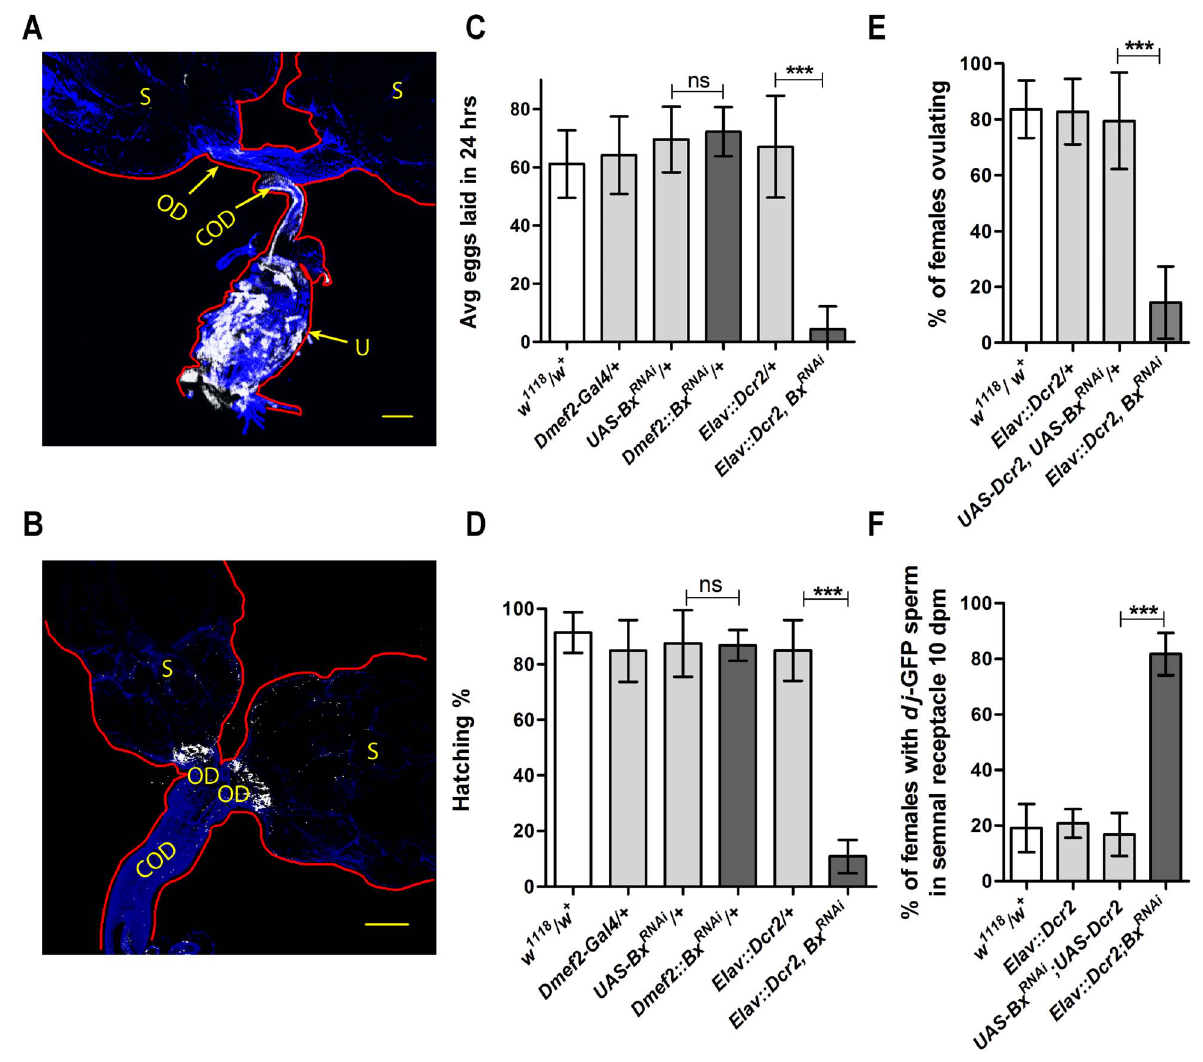
Figure 3. Bx function in the neurons is essential for the normal female reproduction. In order to test in which of the tissues was Bx essential for the female reproduction Bx was knocked down in the muscles ( Dmef2 -Gal4) and neurons ( Elav -Gal4) individually. (A) Dmef2 -Gal4 driven expression of mCD8GFP showed its expression in the muscles of uterus (U), common oviduct (COD) and oviduct (OD) (blue-Phalloidin-TRITC, white- mCD8GFP). (B) Elav -Gal4 driving UAS- Syt eGFP (Green) expression showed innervations of the neurons onto the female reproductive system muscles which include OD, COD and peritoneal sheath (S) (also see Figure S2). (C, D) Knock down of Bx in the neurons but not in the muscles reduces fecundity (C) and fertility (D) (C & D- unpaired t-test with Welch’s correction, ***, p , 0.0001) (no of eggs tested . 1000 ( w 1118 and controls), ,